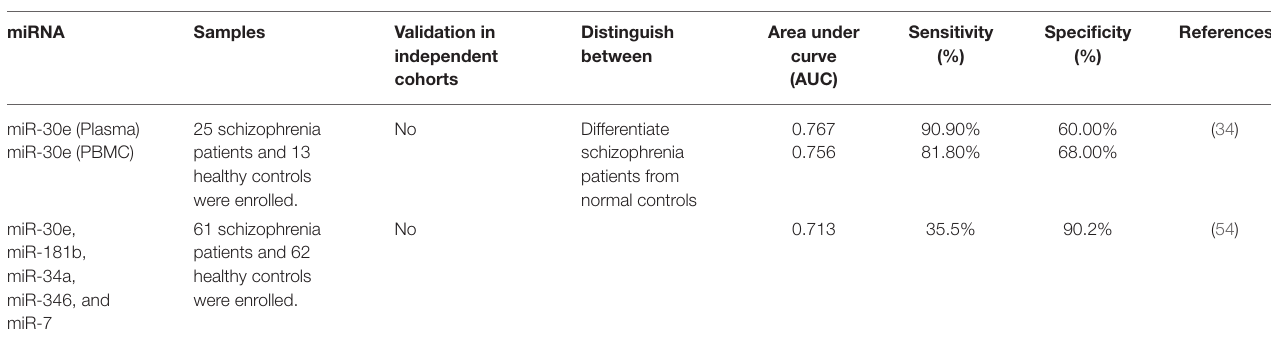
TABLE 6 | Diagnostic role of miRNAs in schizophrenia.